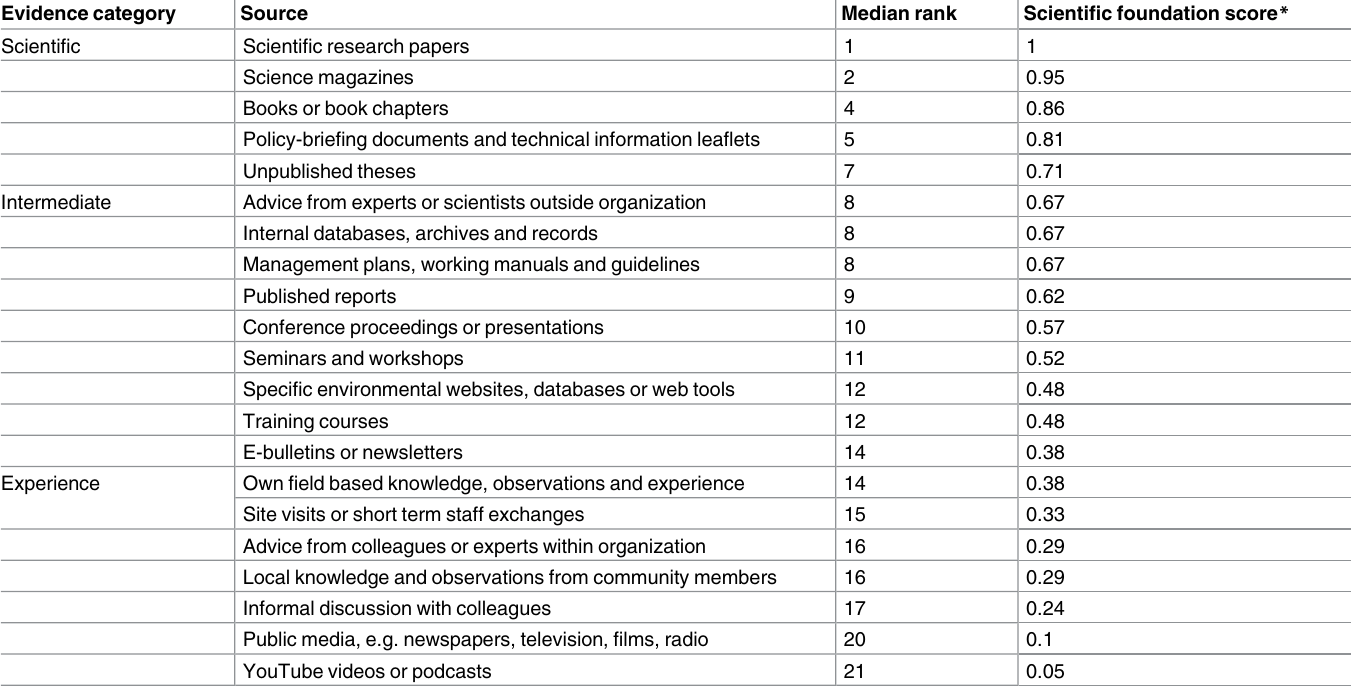
Table 1. Type of information sources included in the questionnaires answered by Brazilian protected area managers, classified according to the level of scientific rigour (scientific foundation score) and categorised as scientific evidence, intermediate evidence and experience-based evidence.